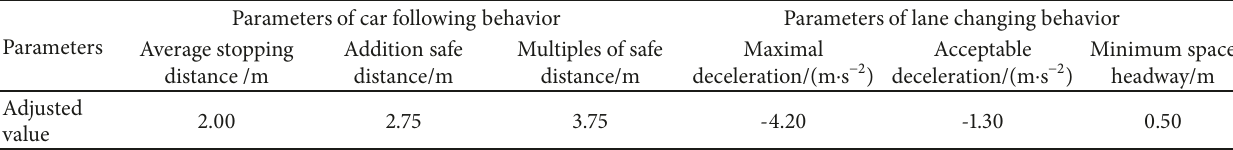
Table 3: Calibrated parameters of the microcosmic simulation model.